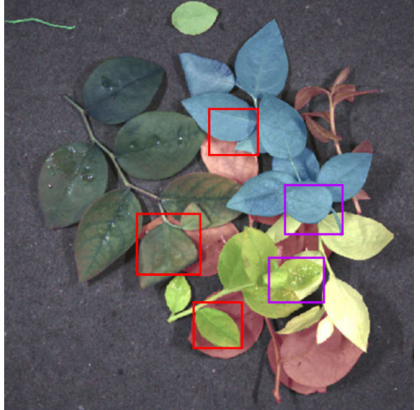
Figure 2. Example of an image from the occluded plants dataset with normal and complex occlusion patches. The red windows illustrate some locations where normal occlusion patches are present, and the purple windows show some locations of complex occlusion patches.